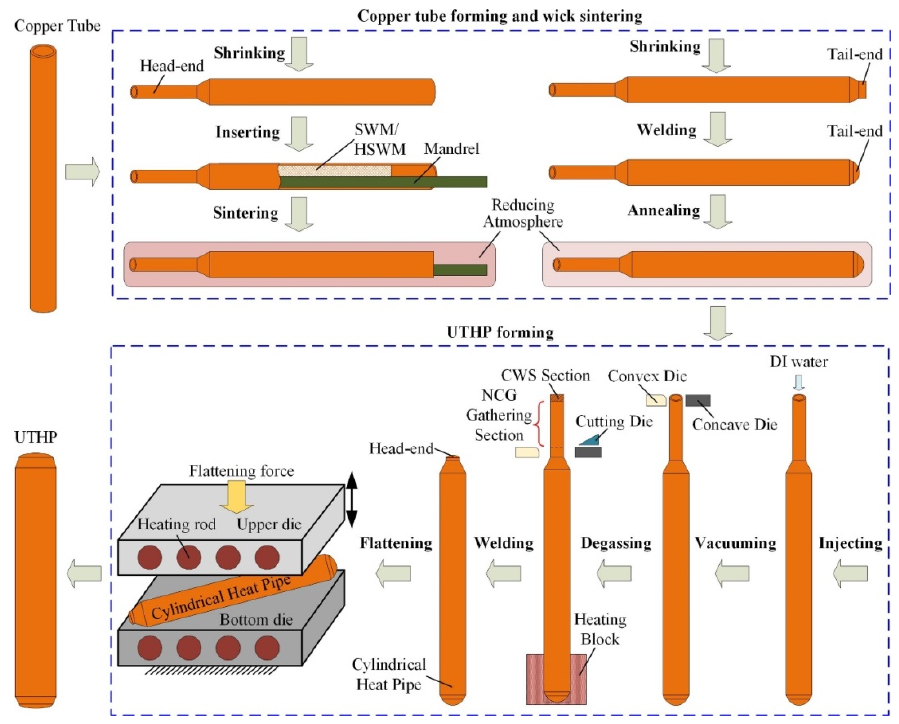
Figure 4. Flow chart of the main manufacturing process of ultra-thin heat pipes [18].